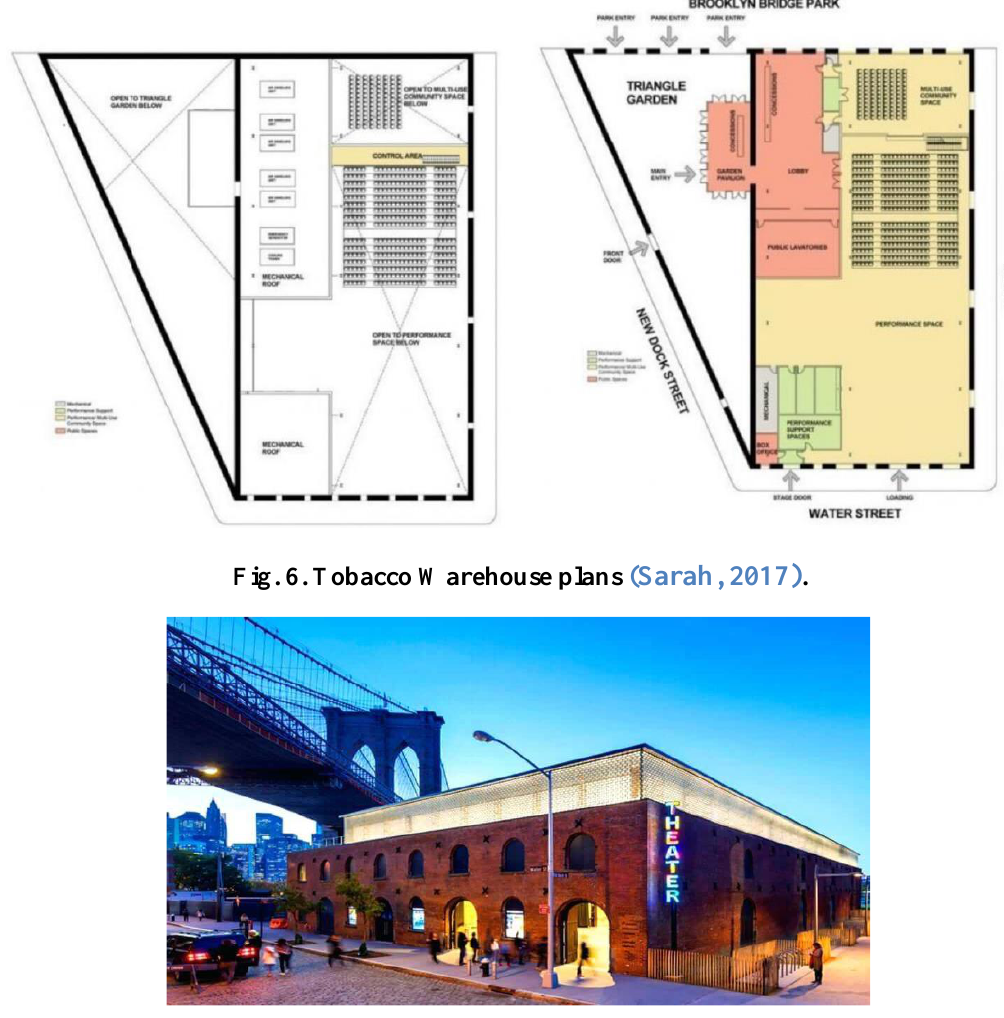
Fig. 7. Tobacco Warehouse elevation ( Sarah, 2017) .